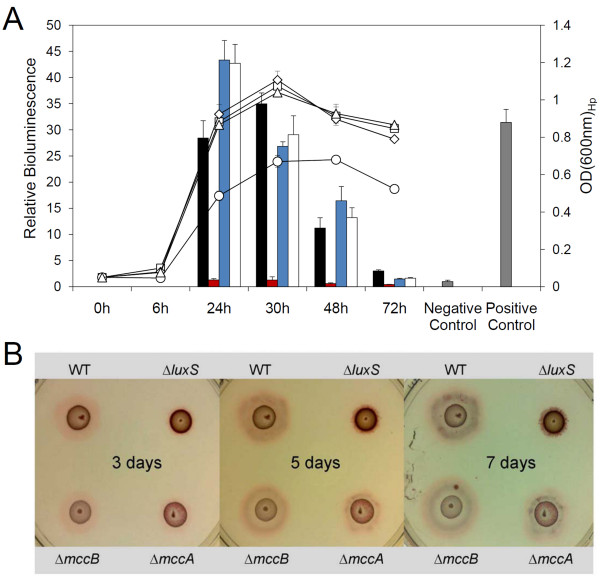
The ΔluxSHp mutant of H. pylori strain J99 lacks AI-2 and is non-motile unlike other mutants deficient in cysteine biosynthesis. (A) AI-2 production in J99 wild-type (black column), ΔluxSHp (red column), ΔmccBHp (blue column) and ΔmccAHp (white column) mutants was measured. Strains were grown in Brucella broth, and aliquots were removed at 24 h, 30 h, 48 h and 72 h to assess the optical density (wild-type, square; ΔluxSHp, diamond; ΔmccBHp, circle; ΔmccAHp, triangle) and the amount of AI-2 in the filtered culture supernatant using the V. harveyi bioassay. AI-2 activity is shown as a relative bioluminescence (corrected by OD600nm of H. pylori) in the presence of H. pylori culture supernatants over the negative control (Brucella broth alone). A diluted in vitro synthesised AI-2 sample was utilised as a qualitative positive control [8]. Bioluminescence induced by wild-type, ΔmccBHp, and ΔmccAHp strains was significantly greater than that induced by the ΔluxSHp mutant, as determined by paired Student's t-test (p < 0.001). The lines represent the growth (OD, righthand axis) and the bars represent the AI-2 activity (bioluminescence, lefthand axis). (B) 5 μl of liquid culture (24 h) of the wild-type, ΔluxSHp, ΔmccBHp and ΔmccAHp mutants was seeded on each quarter of a soft agar plate. After 3, 5 and 7 days of incubation, the motility halo of each strain was recorded using a digital camera. All experiments were done in triplicate: a representative experiment is shown and the mean results are presented in the text.